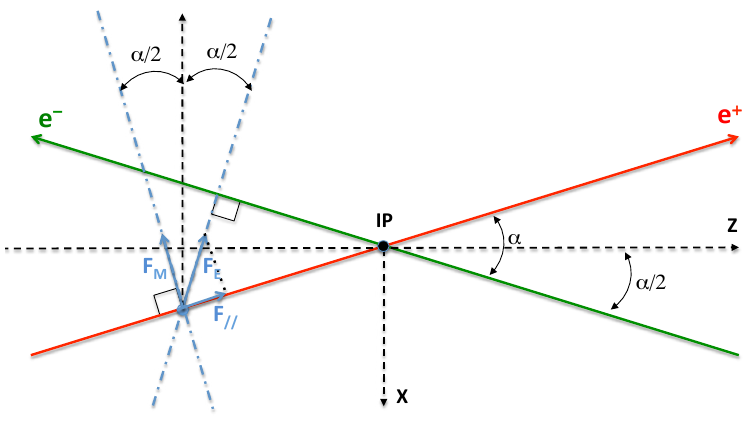
Figure 2 . Schematic view of the electric and magnetic attractive Lorentz forces ~F on each positron from the opposite electron bunch, upon bunch crossing at the interaction point (IP). Similar forces from the positron bunch a(cid:11)ect each electron. From ref. [15]. frame, the magnetic (cid:12)eld created by the (cid:12) = 1 electrons is B = E=c , such that F